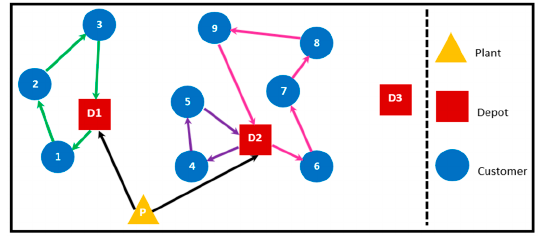
Figure 1. Example of a LIRP with 3 depots and 9 customers.